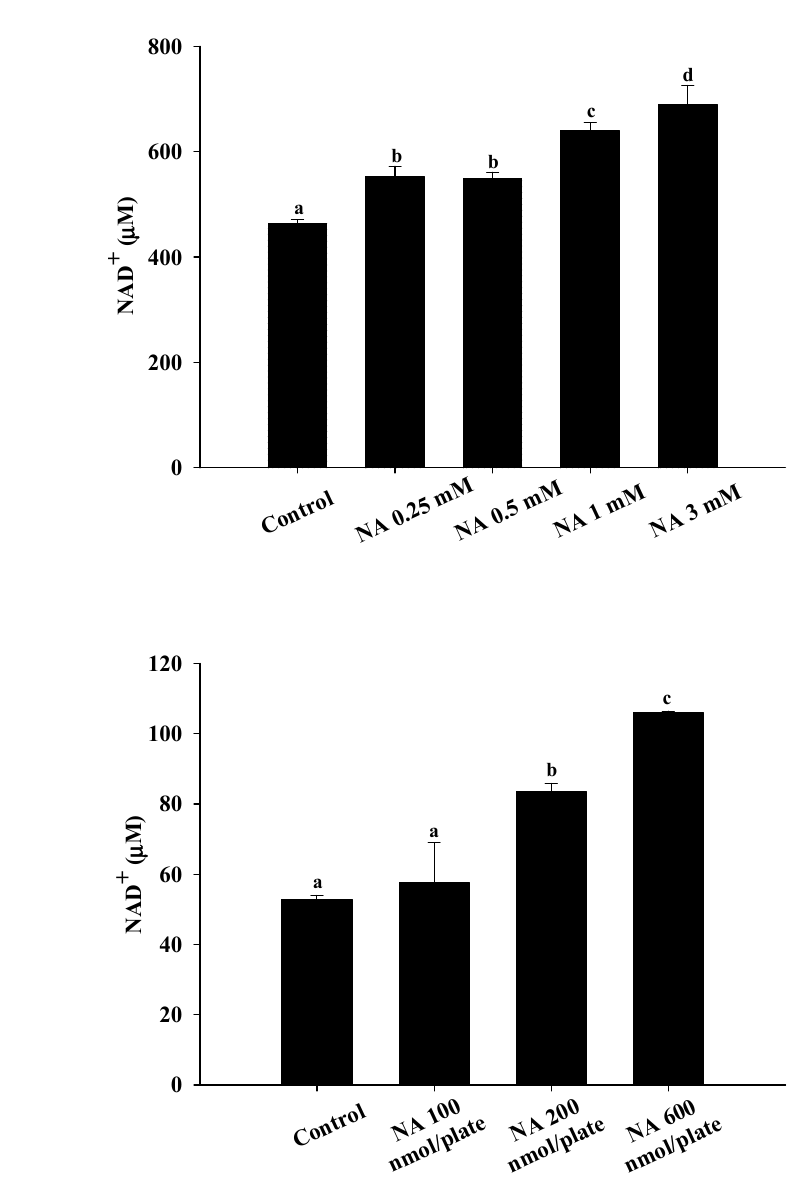
Figure 1. Effects of nicotinic acid (NA) on the intracellular nicotinamide adenine dinucleotide (NAD + ) levels in Hs68 cells and Caenorhabditis elegans . ( a ) Hs68 cells were cultured in medium containing 0, 0.25, 0.5, 1, and 3 mM NA for 24 h. ( b ) C. elegans were grown on nematode growth medium (NGM) plates containing 0, 100, 200, and 600 nmol NA/plate in the center of the top surface of NGM for seven days. The intracellular NAD + levels in Hs68 cells and C. elegans were measured. Values (mean ± SD, n = 3 independent experiments) not sharing a common letter are significantly different ( p < 0.05).